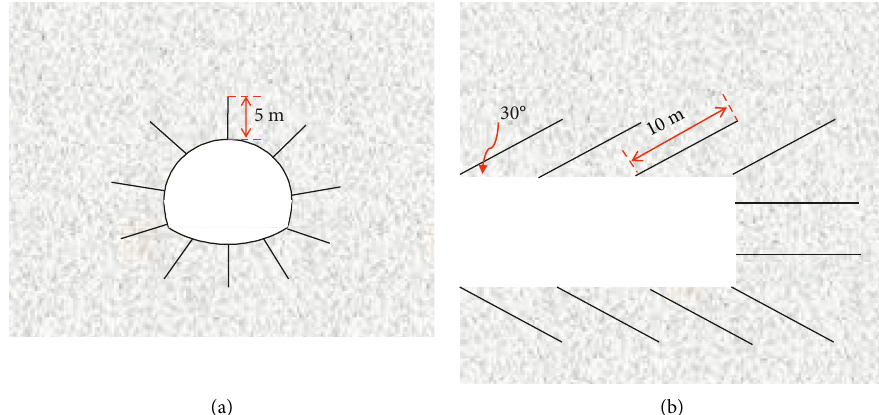
Figure 10: Layout of modified blasting holes in surrounding rock. (a) Front view of drilling and blasting. (b) Side view of borehole